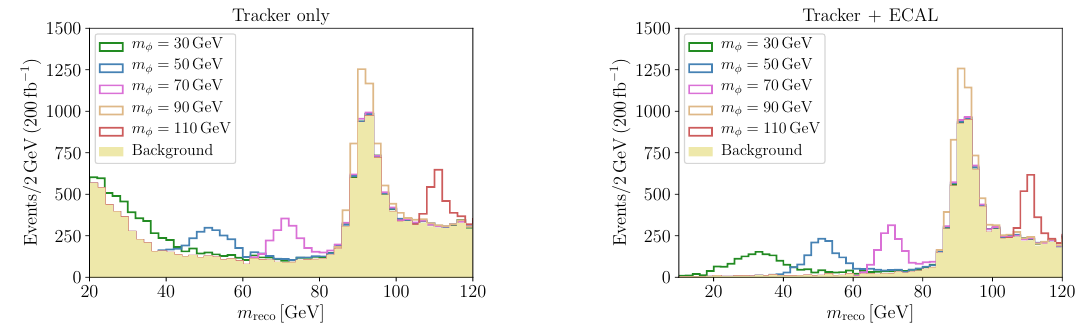
+ (cid:22) 1 Figure 6 . Distributions of m (cid:0) ) (cid:30) channel for 200 fb (cid:0) reco for light scalars in the ( Z ! (cid:22) after cuts with a tracking detector (left) and a general purpose detector (right) with tracking and electromagnetic calorimeter. Results are shown for several scalar masses with (cid:20) =